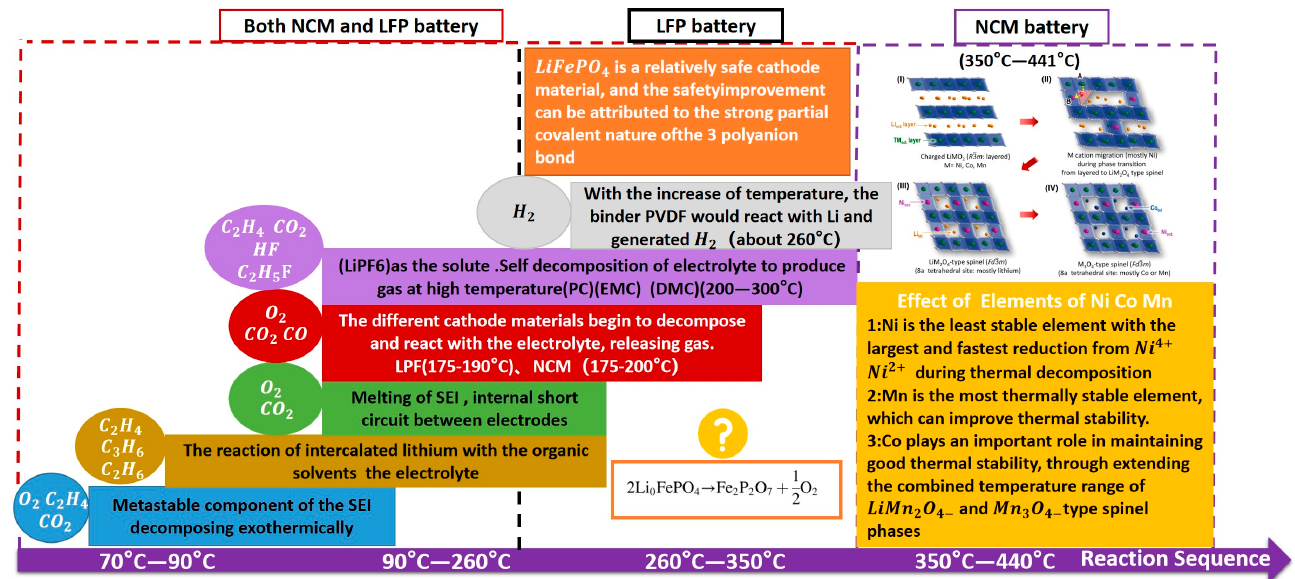
Figure 9. Investigation of gas generation and phase change sequence during TR of NCM battery and LFP battery [12,42,43,47,49–63].